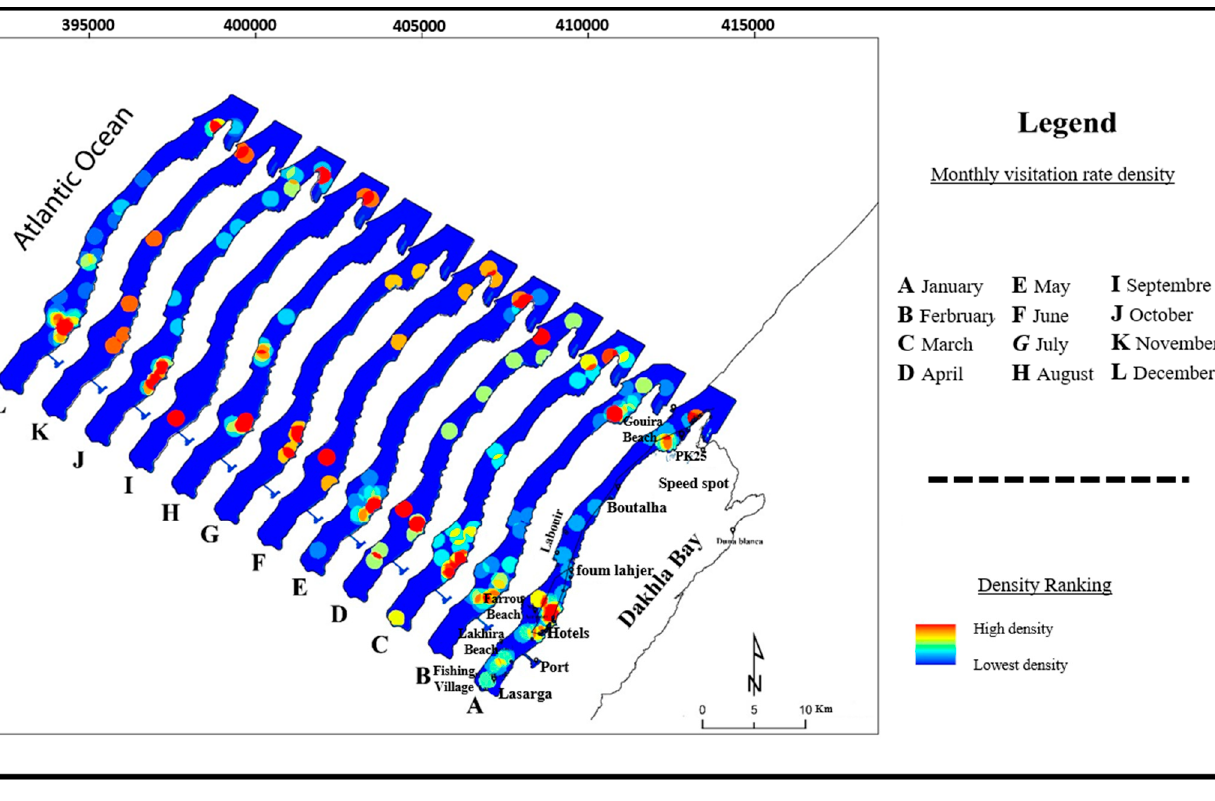
Figure 5. Monthly visit rate density.